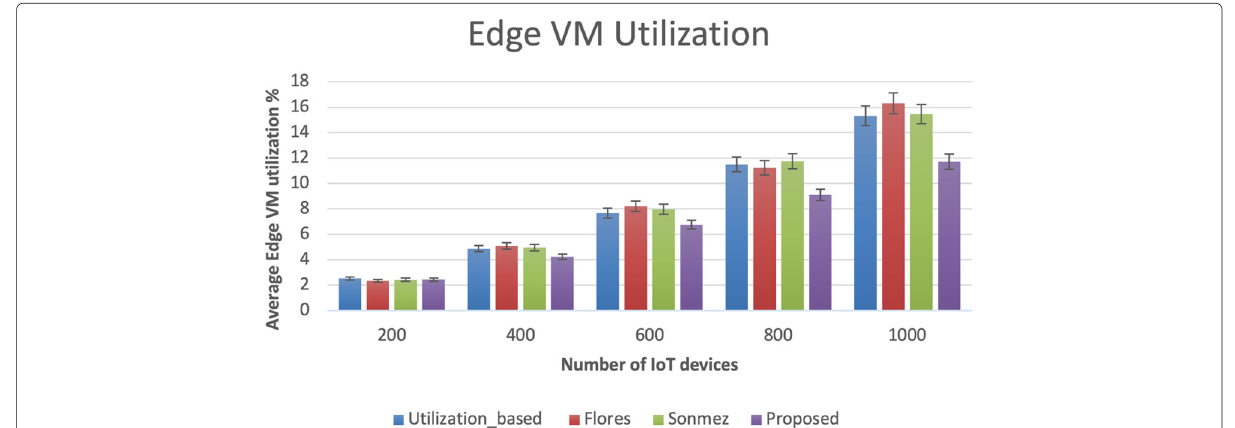
Fig. 13 Edge server utilization of the proposed approach with other related approaches part